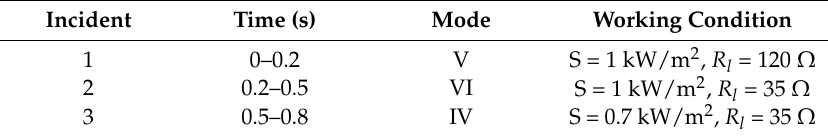
Table 3. Description of simulated working condition 1.